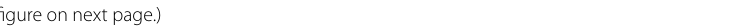
a See Fig. 1 for the location of S1 and